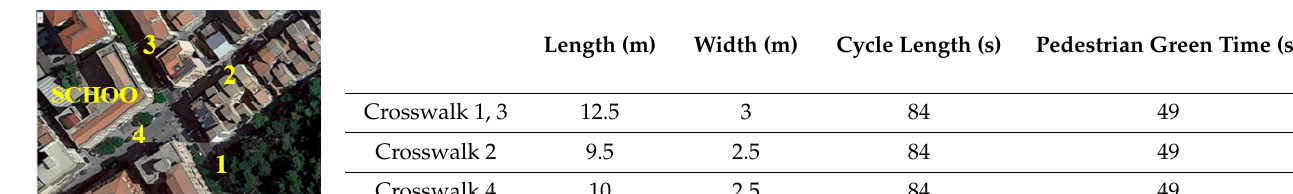
Table 1. Basic characteristics of crosswalks in Enna, Italy.